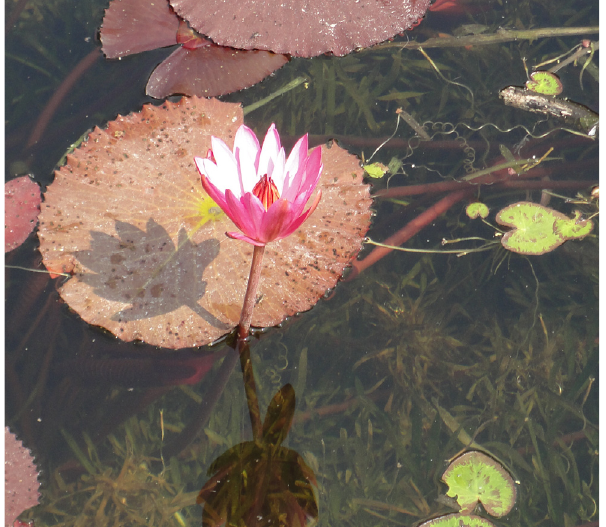
Fig. 11. Flowering twig of Nymphaea rubra Roxburgh ex An- drews